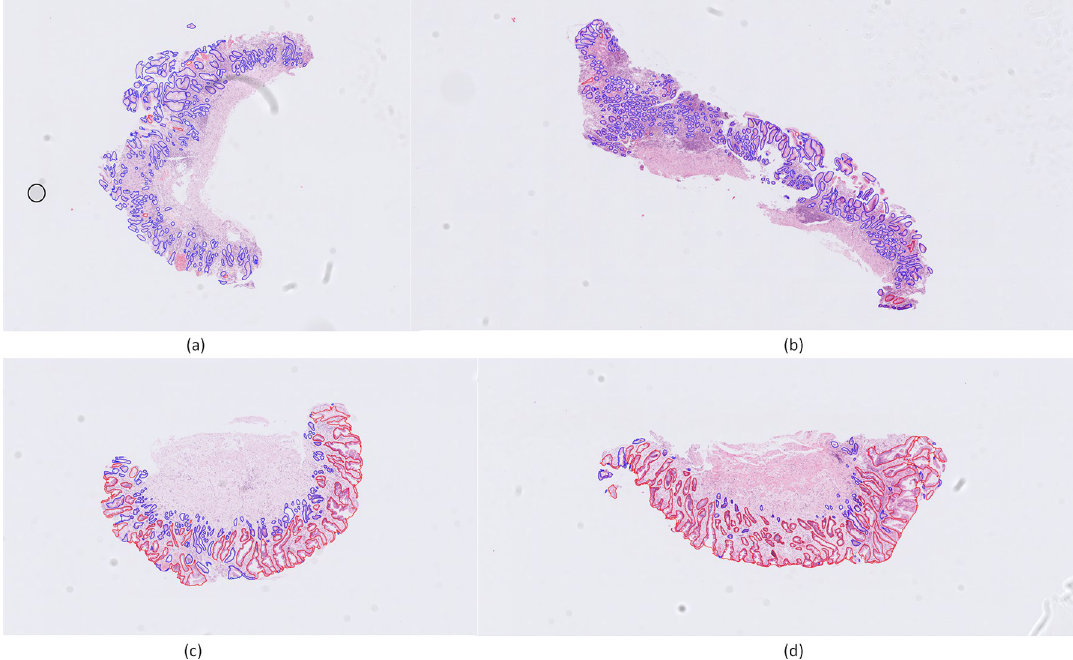
Fig 7. Gland classification using the GAGL-VTNet model on four WSI: a-b) normal cases, c-d) IM cases. Blue color denotes the glands that have been detected as normal and red color denotes the glands that have been detected as IM glands.